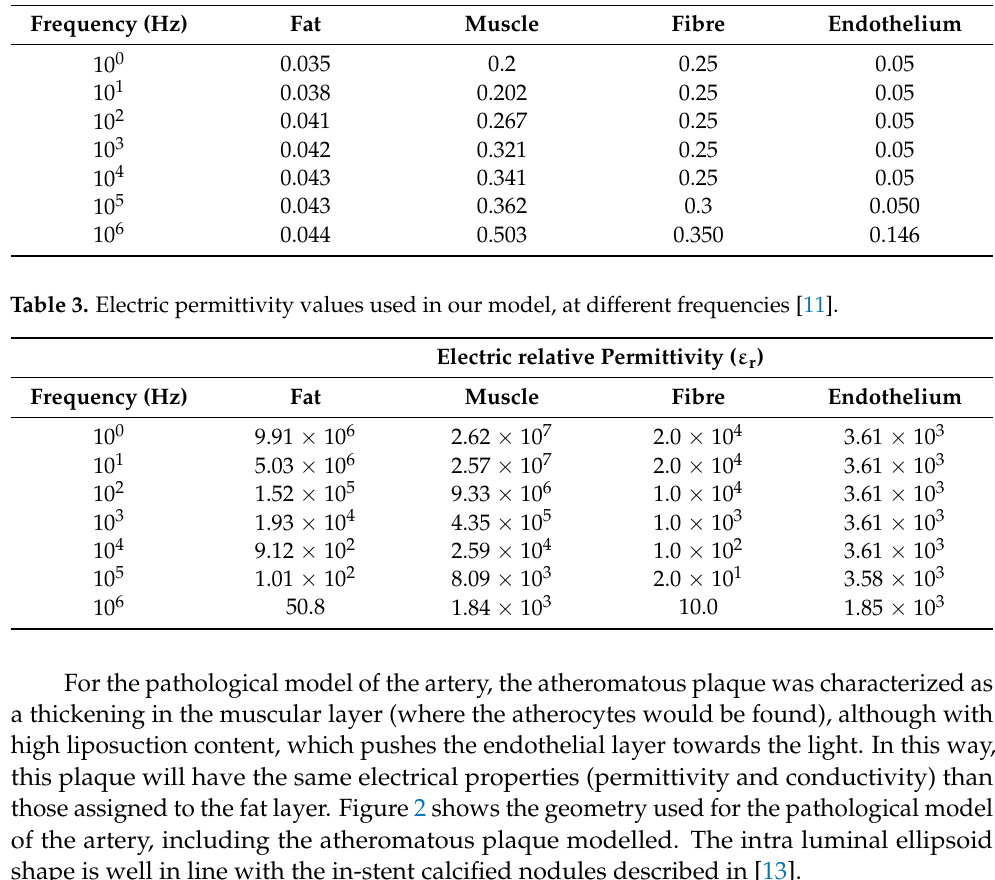
Table 3. Electric permittivity values used in our model, at different frequencies [11].